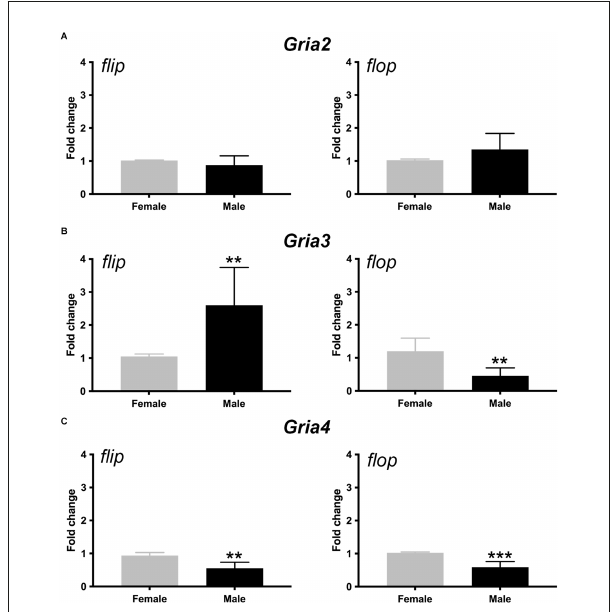
FIGURE7 Sex differences in the expression of AMPAR flip and flop splice variants in the cochlea. (A–C) Bars show the fold change ( ± SD) in mRNA for Gria2 (A) , v3 (B) , and Gria4 (C) flip and flop splice variants in male (black) when compared to female (gray) cochleae. Independent samples t -test, ** p < 0.05, *** p < 0.0005, see “Results” Section for specific p